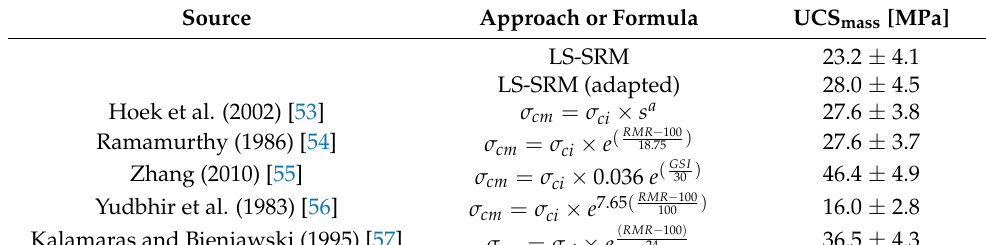
Table 8. Comparison of the rock mass strength using the LS ‐ SRM approach and empirical equations based on empirical rock mass classification schemes.